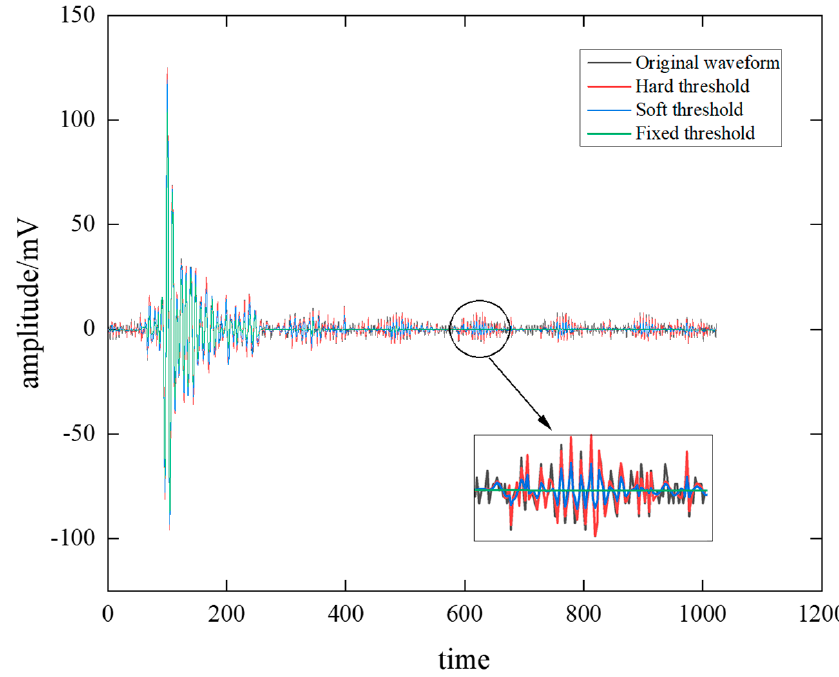
Figure 6. Acoustic emission original waveform of signal A and wavelet denoising.